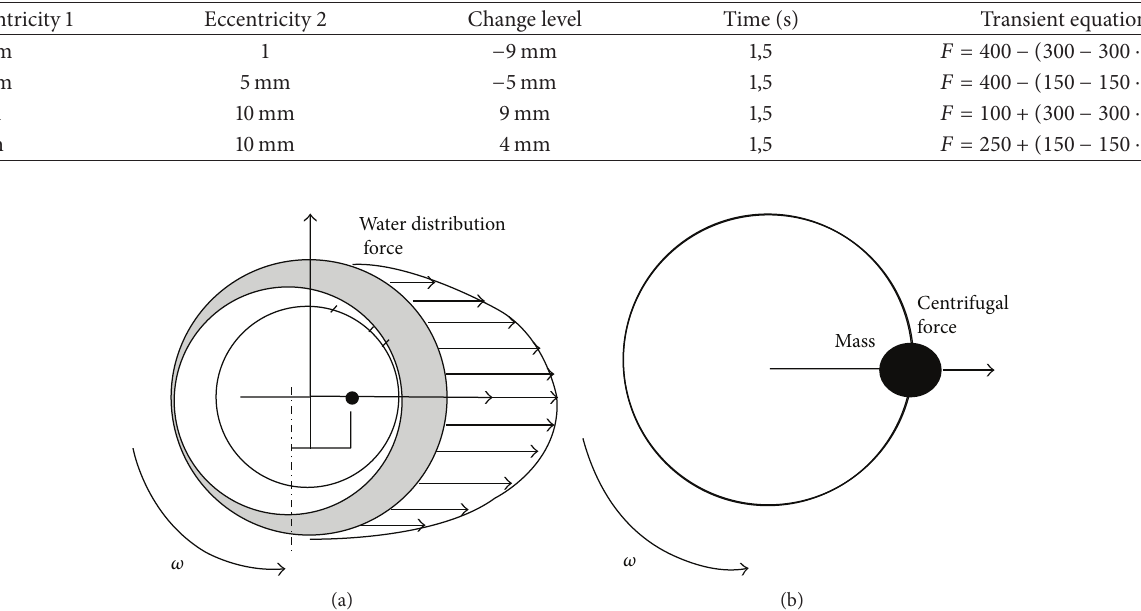
Table 2: Design matrix of level change.